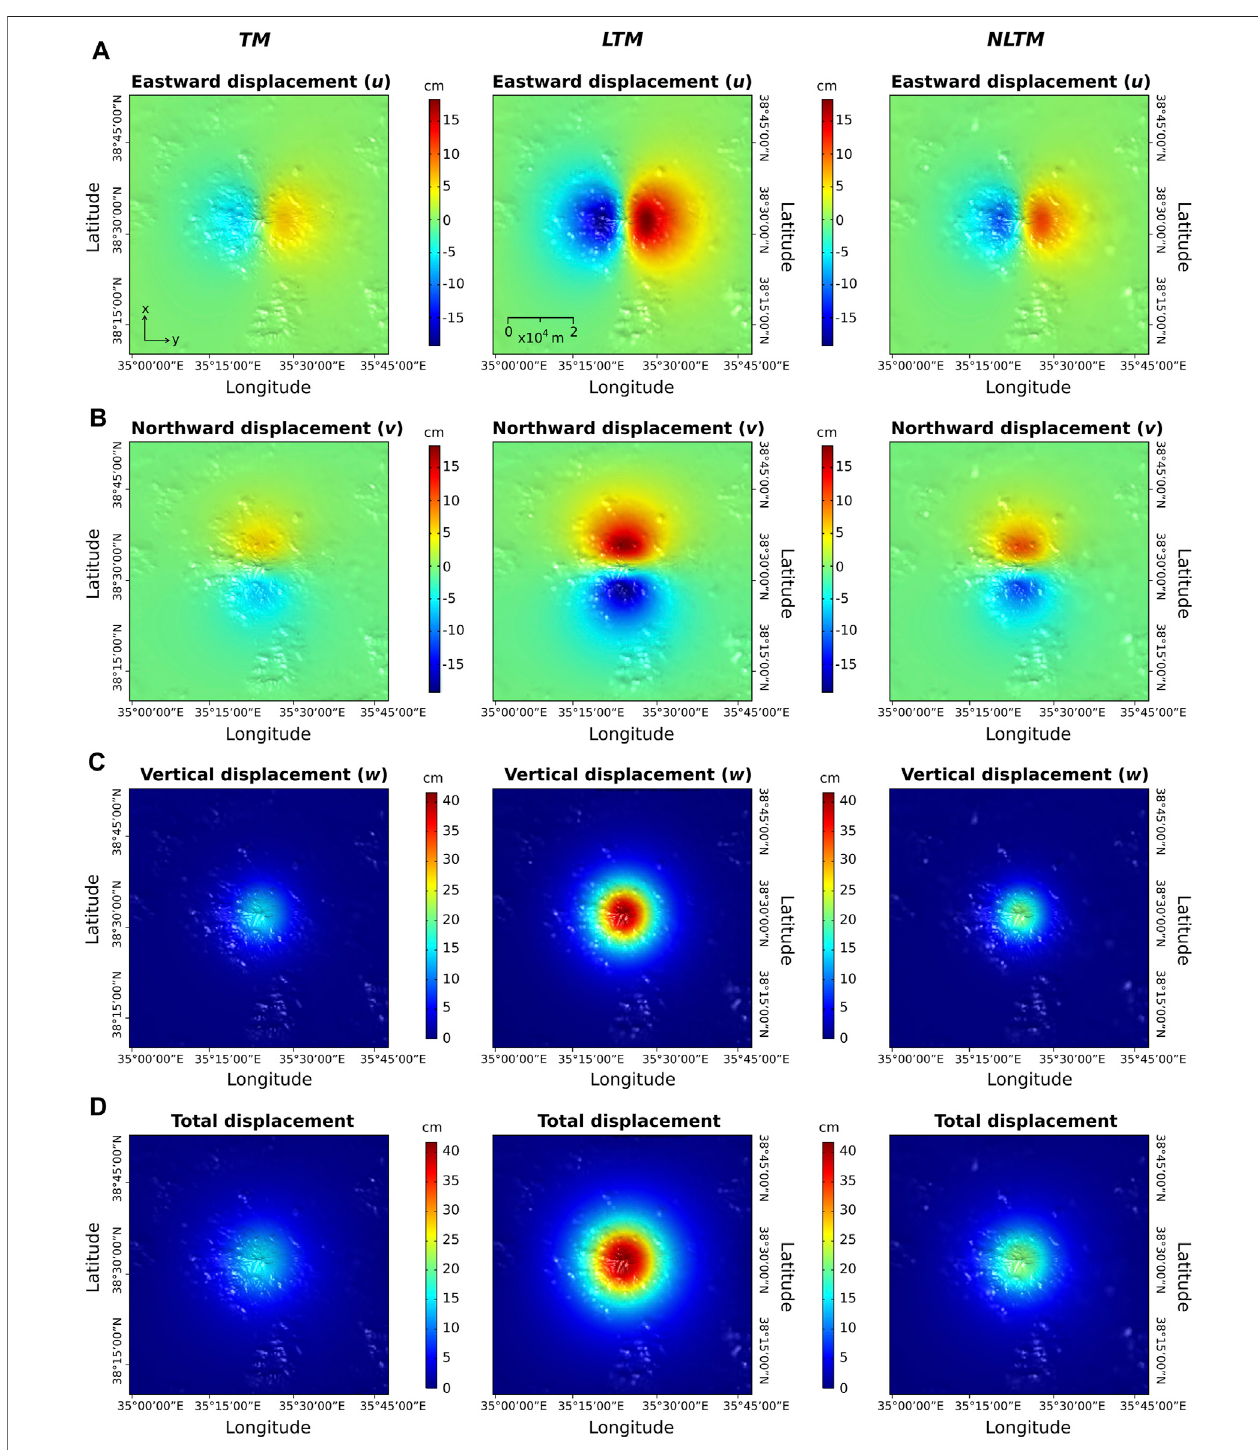
FIGURE 5 | Surface displacements at Erciyes Da ğ from generic TM, LTM and NLTM simulations using parameters reported in Table 3 . (A – D) show horizotal eastwards ( u ), horizontal northwards ( v ), vertical ( w ) and total displacements, respectively. The color bars depict the same range in values for each deformation component, facilitating comparison of variations in displacement magnitudes across different models.